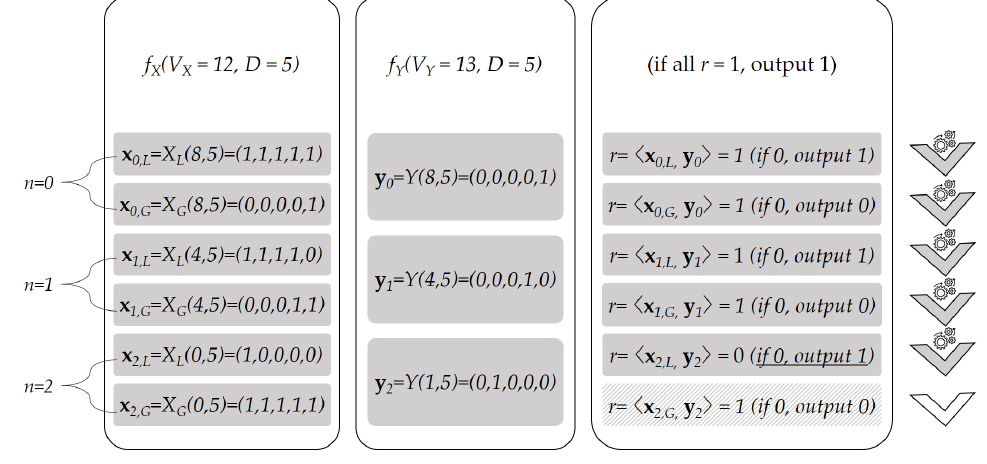
Figure 3. Example with D = 5, V X = 12, V Y =